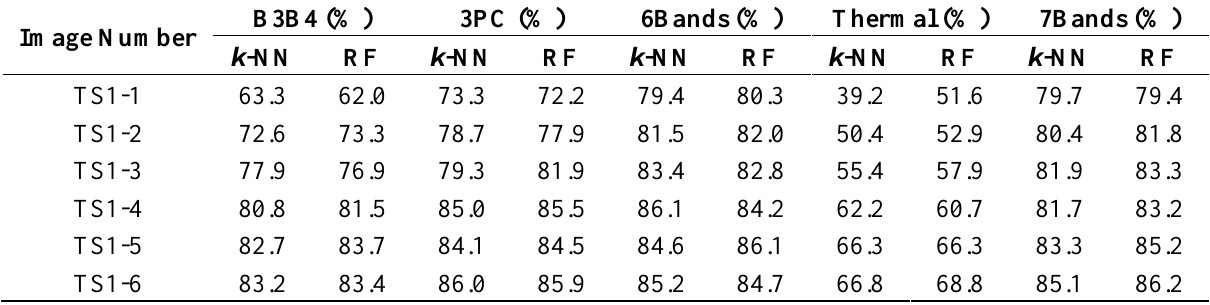
Table 3. Overall Accuracy of Level 2 classification assessed by the polygon-based CV method using five variants of time series of images: B3B4, the combination of band 3 and band 4; 3PC, the first three principal components of all bands; 6Bands, the combination of six bands; Thermal, the thermal band; and 7Bands, the combination of all seven bands. Image